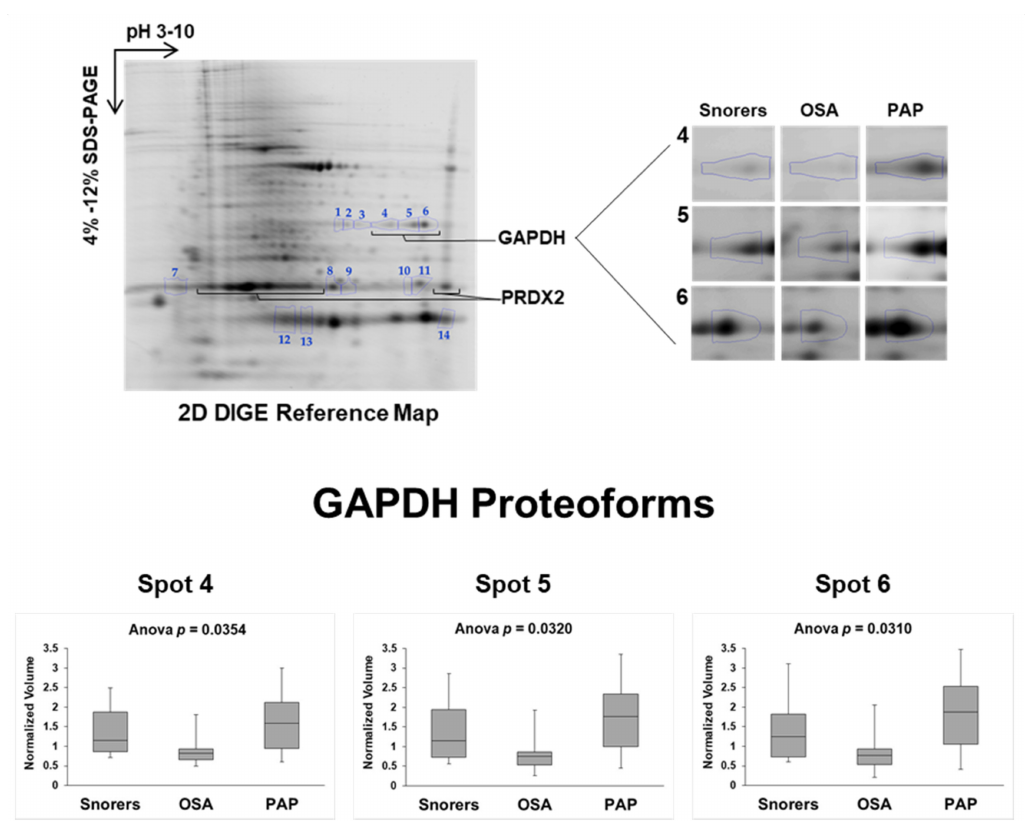
Figure 1. Twodimensionaldifferencegelelectrophoresis(2D-DIGE)referencemapofhemoglobin-depleted red blood cells (RBCs) from Snorers subjects and Obstructive Sleep Apnea (OSA) patients before and after positive airway pressure (PAP) treatment. Fourteen protein / proteoforms spots differentially abundant (fold change ≥ 1.2; Anova p < 0.05) among Snorer RBC and OSA RBC before and after six months of PAP treatment are numbered and indicated with circles on the reference mini 2D-DIGE map image